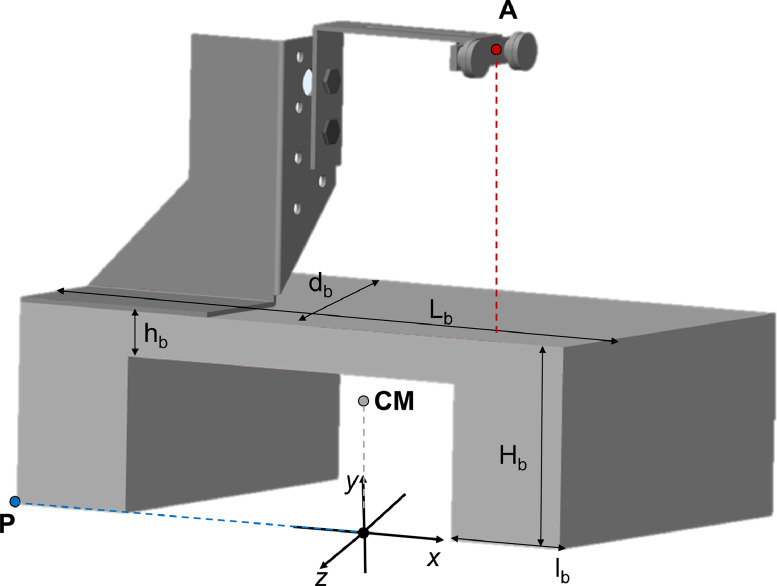
The quoted support base.